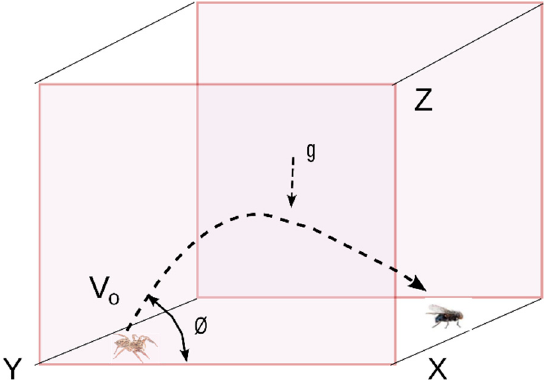
Figure 4. Jumping on the prey [47].